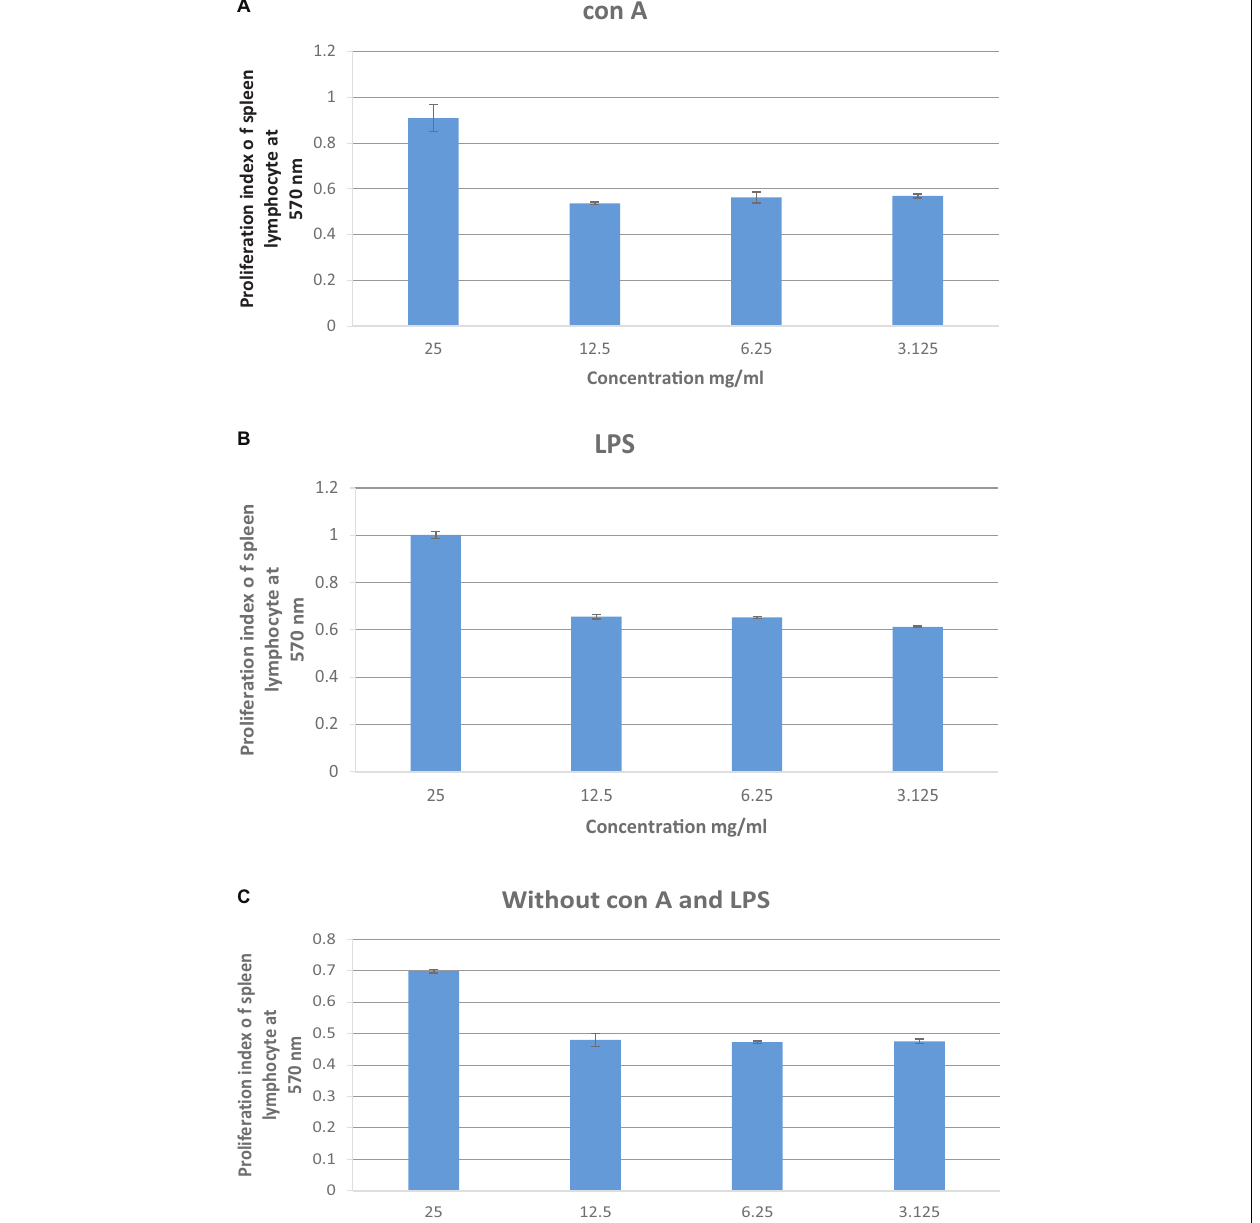
investigated the antiproliferation activity of each extract against selected cell